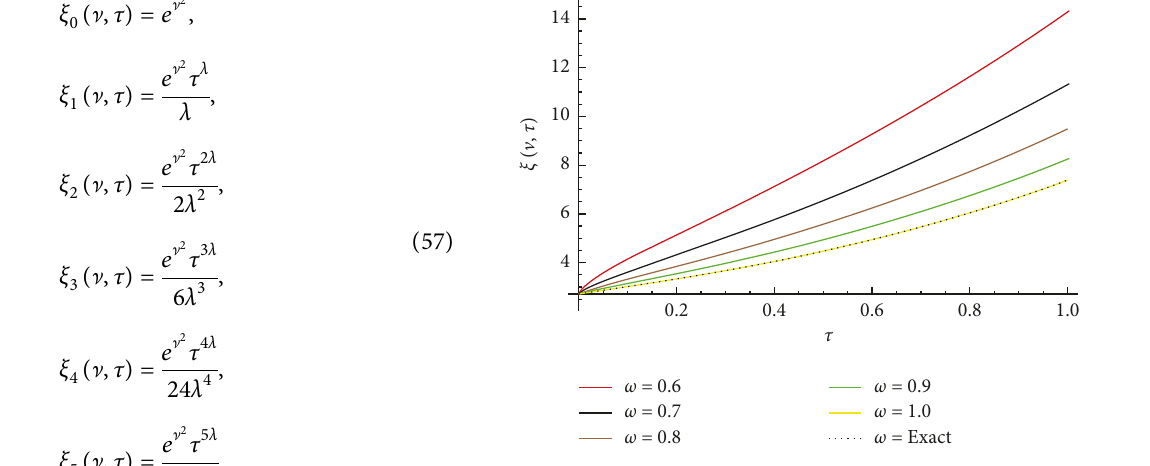
Figure 3: Approximate solutions for different values.